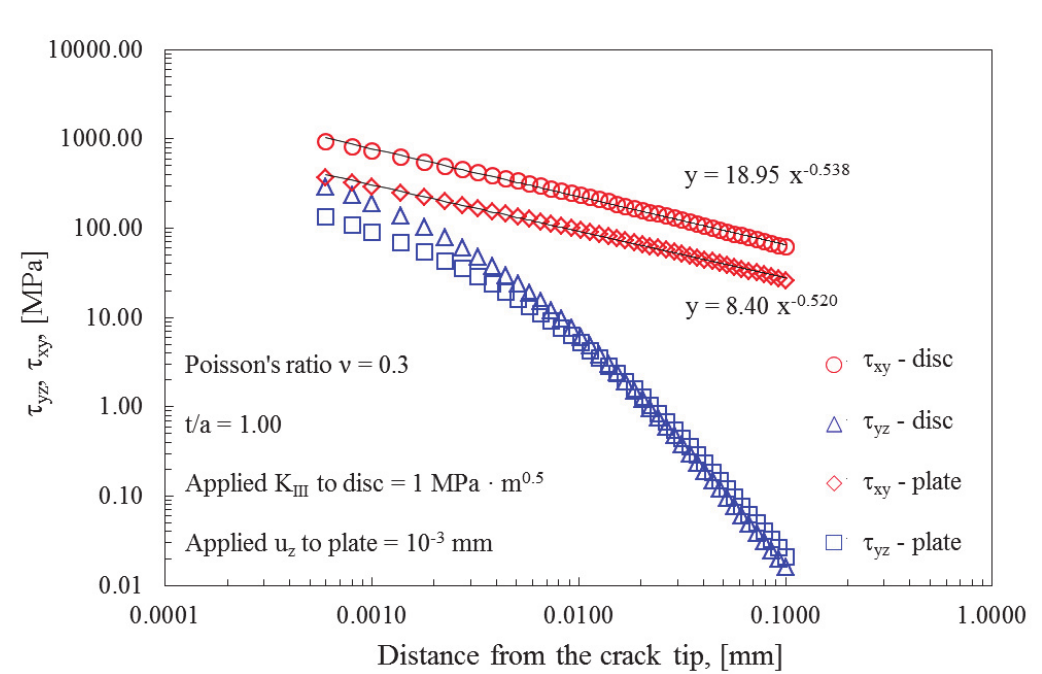
Figure 3: Stresses τ yz and τ xy on crack surface at s = 0 mm from disc and plate surfaces, t/a